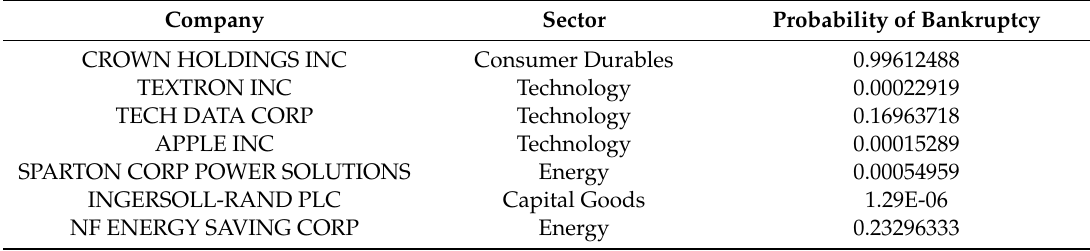
Table 2. Seven listed companies undertaking the probability of bankruptcy